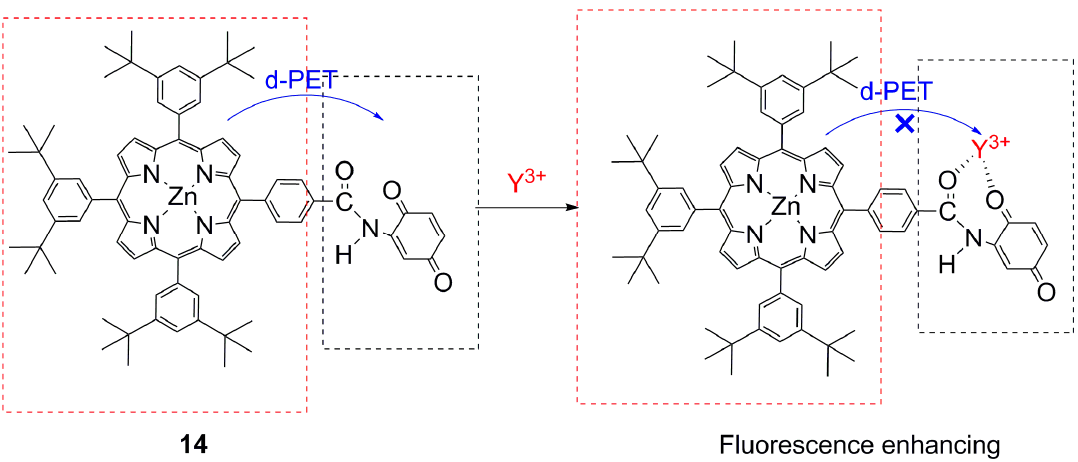
Figure 4. Schematic of of zinc porphyrin–quinone-linked dyad for detection of Y 3 + . Reproduced from ref. [44].